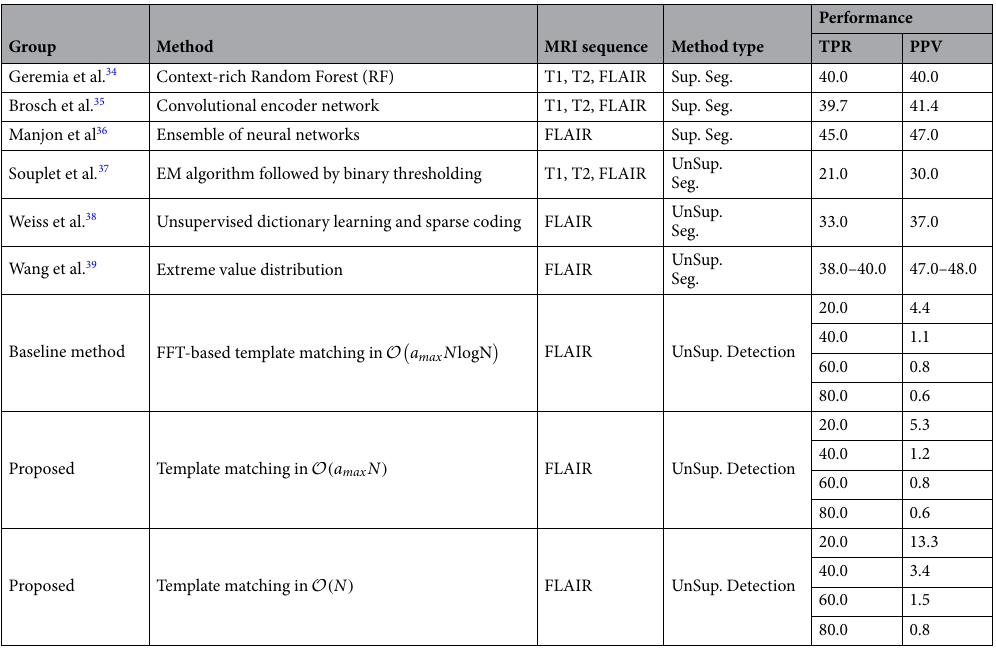
Table 2. Comparison of the existing Methods on MICCAI MSLS 2008 Training Data 36 . (TPR = TPF; PPV = 1 − FPF).